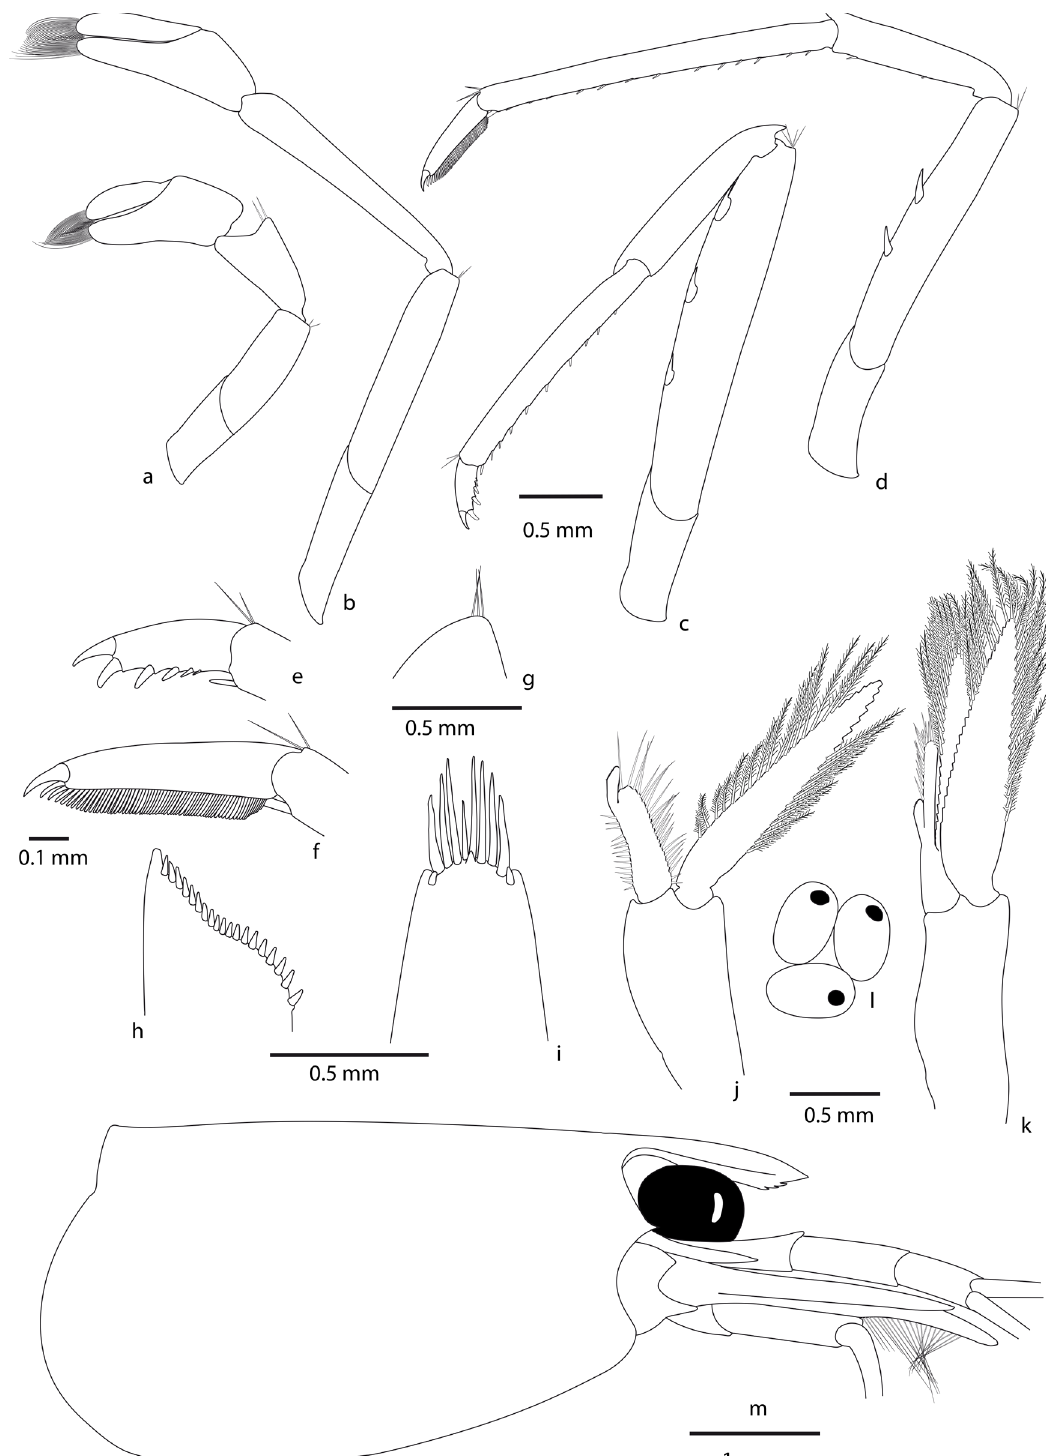
Fig. 10. Caridina typus H. Milne Edwards, 1837. a . First pereiopod. b . Second pereiopod. c . Third pereiopod. d . Fifth pereiopod. e . Dactylus of third pereiopod. f . Dactylus of fifth pereiopod. g . Pre- anal carina. h . Uropodal diaeresis. i . Telson. j . First male pleopod. k . Second male pleopod. l . Eggs. m . Cephalothorax. MNHN-IU-2018-2825 (a–c, e, h), MNHN-IU-2018-2842 (d, f), MNHN-IU-2018 -2826 (g, j–k), MNHN-IU-2018-2833 (i), MNHN-IU-2018-2832 (l) and MNHN-IU-2018-2824